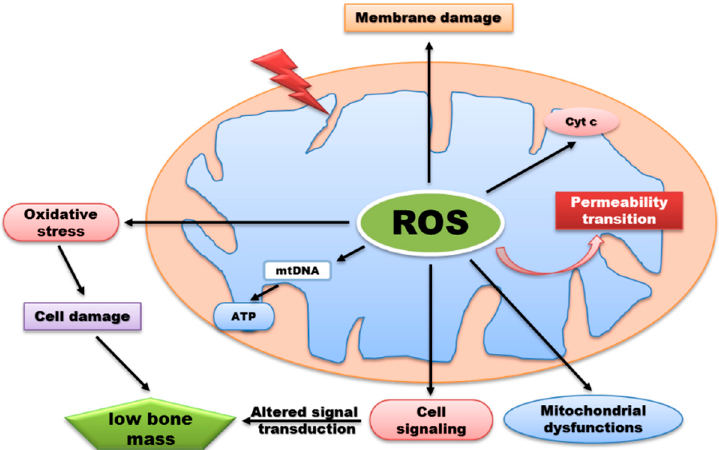
Figure 2. ROS generation by mitochondria can influence various biological functions but excessive production of ROS lead to signaling alteration, membrane damage, release of cytochrome c, and oxidative damage to mitochondrial proteins and DNA. Consequently, oxidative damage can impair synthesis of ATP thereby preventing normal metabolic functions which contributes to a wide range of disease